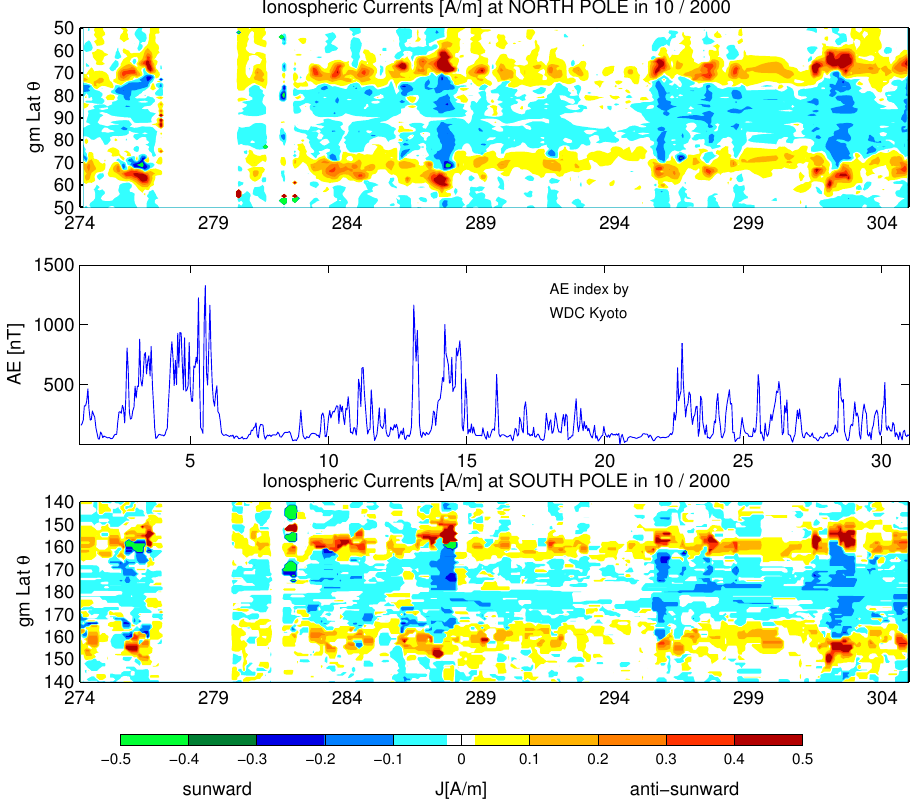
Fig. 2. Ionospheric currents in the polar regions of the northern and southern hemispheres ( θ m : geomagnetic latitudes). For comparison the AE index is plotted in the middle panel. The horizontal time scale spans one month, given as day numbers in MJD2000 format, i.e. the Modified Julian Days are counted from 01.01.2000, 0:00:00 UT.